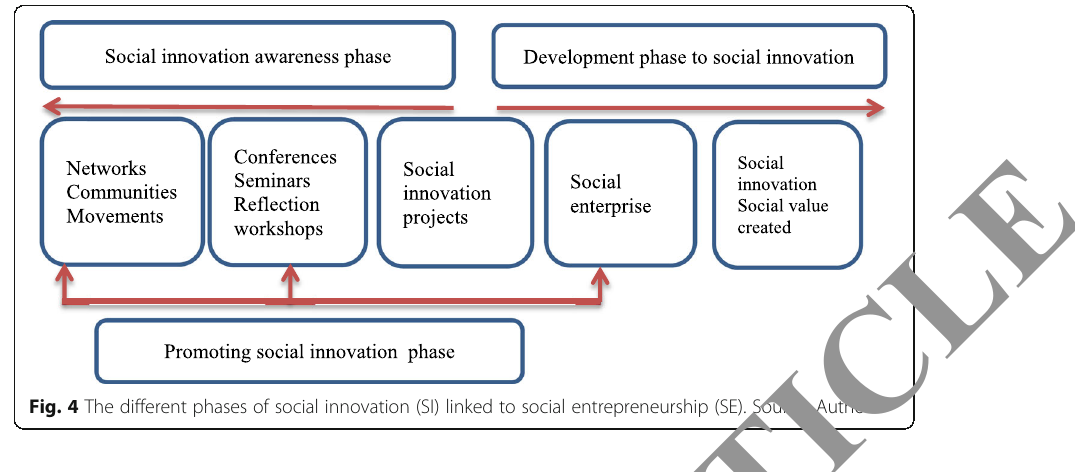
Fig. 4 The different phases of social innovation (SI) linked to social entrepreneurship (SE). Source: